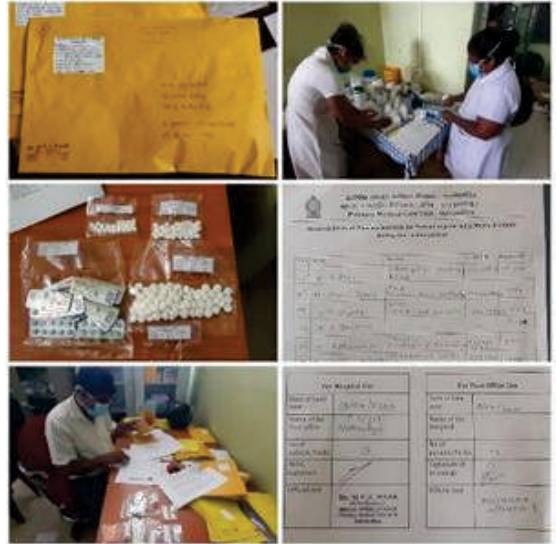
Figure 5: PMCUs arranging supply of clinic drugs by